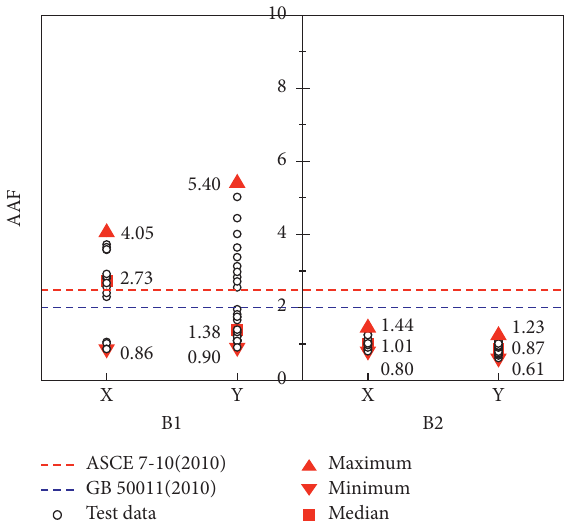
Figure 15: Acceleration amplification factor of the specimen.